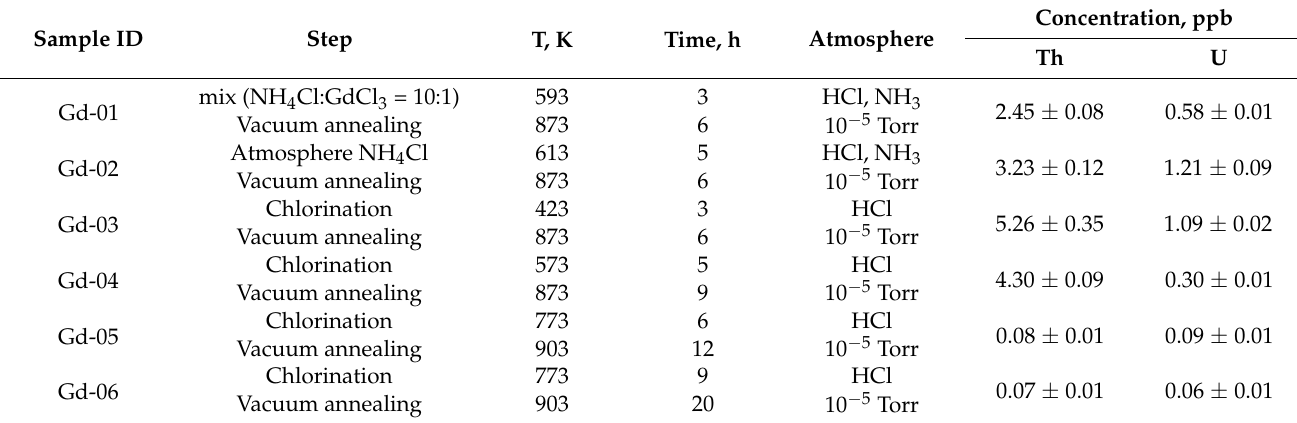
Table 6. The determined concentration of thorium and uranium in GdCl 3 samples synthesized at different conditions. Sample